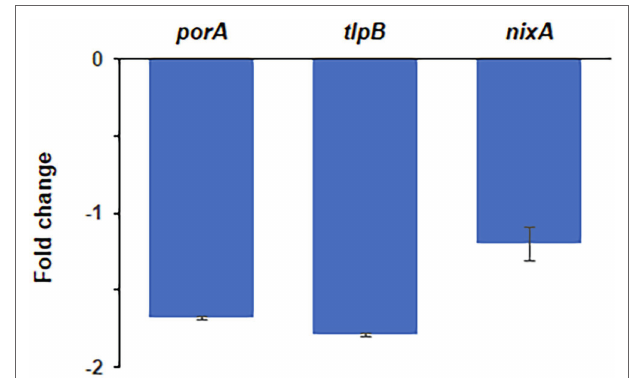
FIGURE 4 | Quantitative real-time PCR (qPCR) analysis of transcript abundance changes of selected genes in response to the exposure to lethal concentrations of the DHP-based HHQ derivative MD7. Total RNA was extracted from H. pylori strain 26695 after 2 h exposure to 4 × MIC (16 mg/L) of MD7. Relative transcription of genes porA , tlpB and nixA in MD7-treated cells with respect to DMSO (vehicle) treated cells are indicated as fold changes. Values correspond to the average of two independent biological samples, each analyzed in three technical replicates. Error bars indicate the